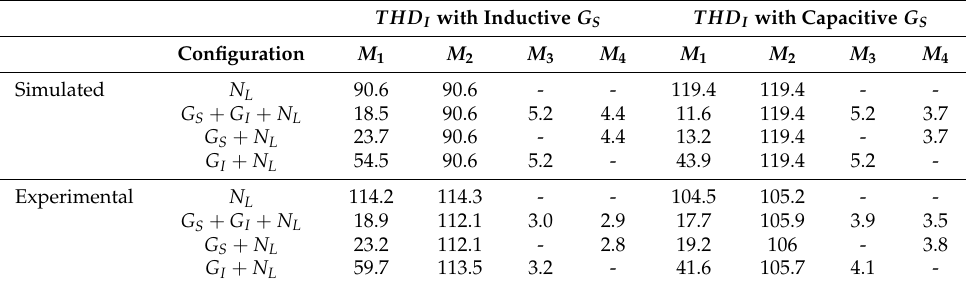
Table 11. Harmonic analysis on points M 1 , M 2 , M 3 and M 4